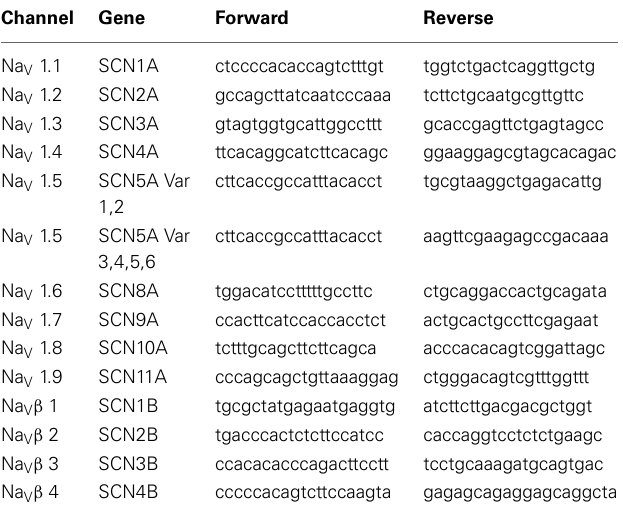
Table 1 | Primer sequences for PCR analyses of human atrial myofibroblast Na + channel complex transcripts.